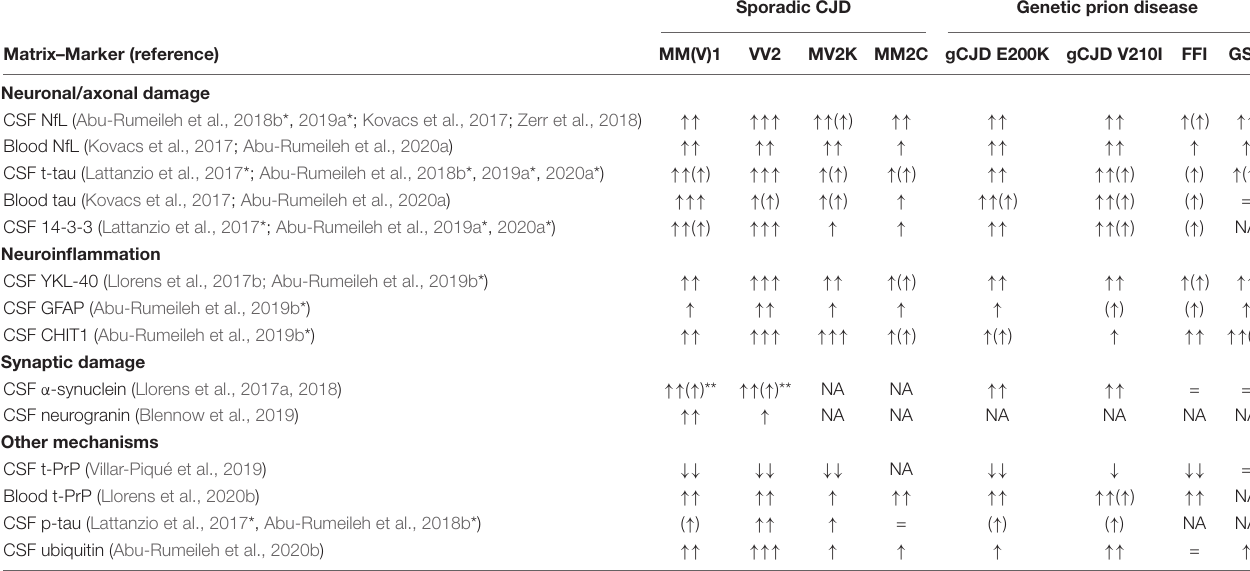
Sporadic CJD Genetic prion